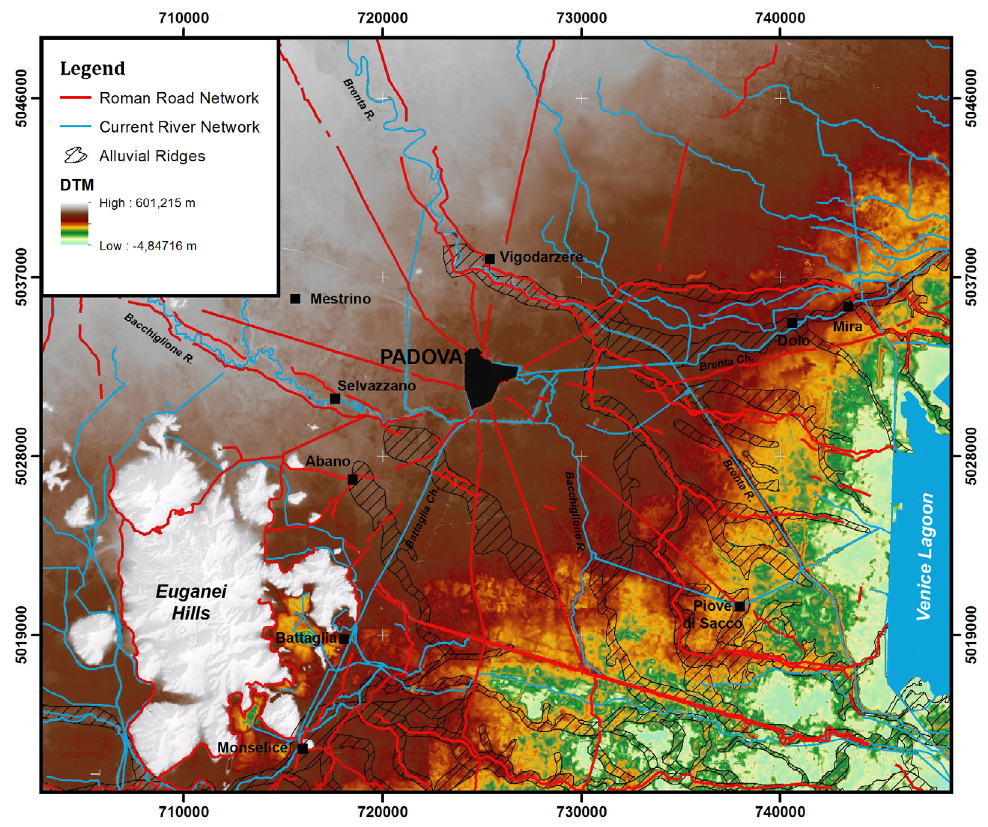
Fig. 5 The relationship between the Roman road network and the natural